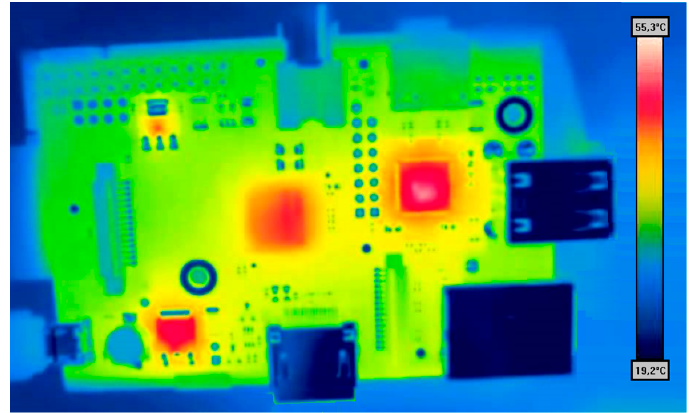
Figure 11. Temperature on the board caught using an infrared camera.